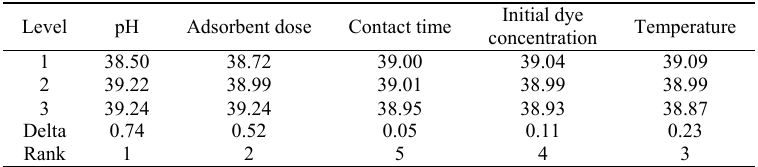
Table 3. Response table of S/N ratios and contribution of each controllable factor